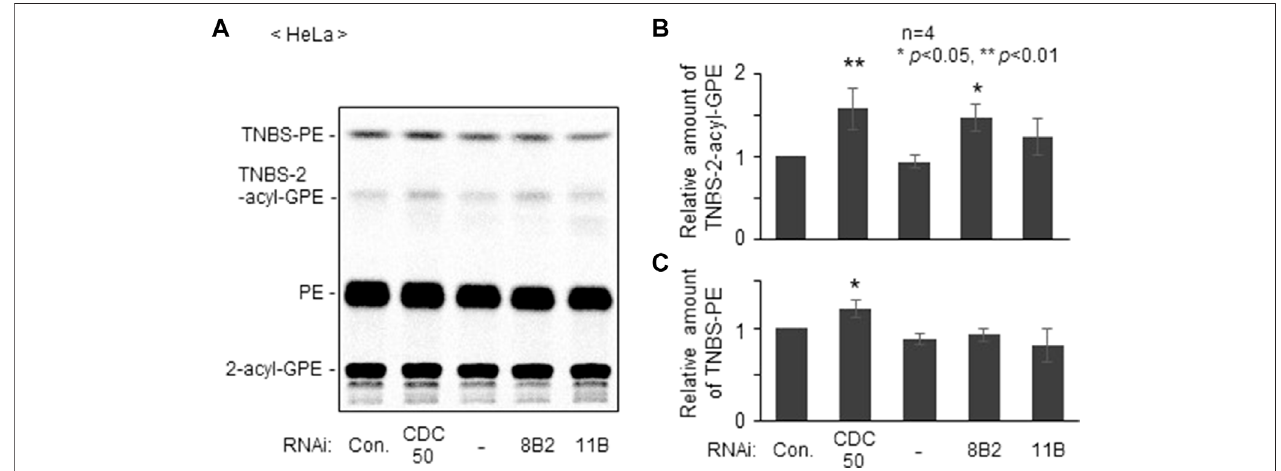
FIGURE2 | Knockdown of ATP8B2 elevates plasmalogens localization in outer lea fl et ofplasma membranes. (A) HeLacells were transfectedfor 54 h withcontrol dsRNA (Con.) and dsRNA against CDC50A (CDC50), ATP8B2 (8B2), or ATP11B (11B), and further cultured in the presence of 14 C-ethanolamine for 18 h. Cells were incubatedwithTNBS,amembraneimpermeableamine-reactivereagent.Totalcellularlipidswereextractedfromequalaliquotsofrespectivecellproteinsaftertreatment of trichloroacetic acid to cleave vinyl-ether bond of plasmalogens and analyzed by TLC. Note that plasmalogens and TNBS-modi fi ed plasmalogens are converted to 2-acyl-GPE and TNBS-2-acyl-GPE, respectively, upon trichloroacetic acid treatment. (B,C) Relative amounts of TNBS-modi fi ed plasmalogens (B) and TNBS- modi fi edPE (C) wererepresentedbytakingasonethoseinHeLacellstransfectedwithcontroldsRNA(Con.)( n =4).Dataindicatemeans±SD.* p < 0.05,** p < 0.01,by one-way ANOVA with Dunnett ’ s post hoc test as compared with control dsRNA-transfected HeLa cells (Con.).